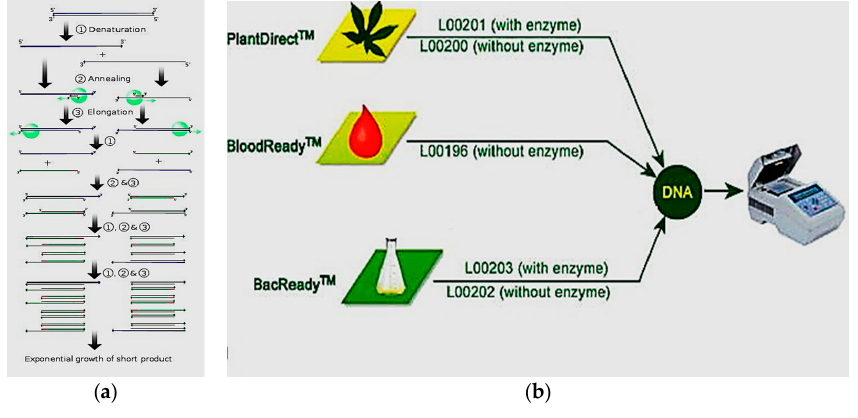
Figure 1. Steps of ( a ) PCR cycle and ( b ) DNA extraction.